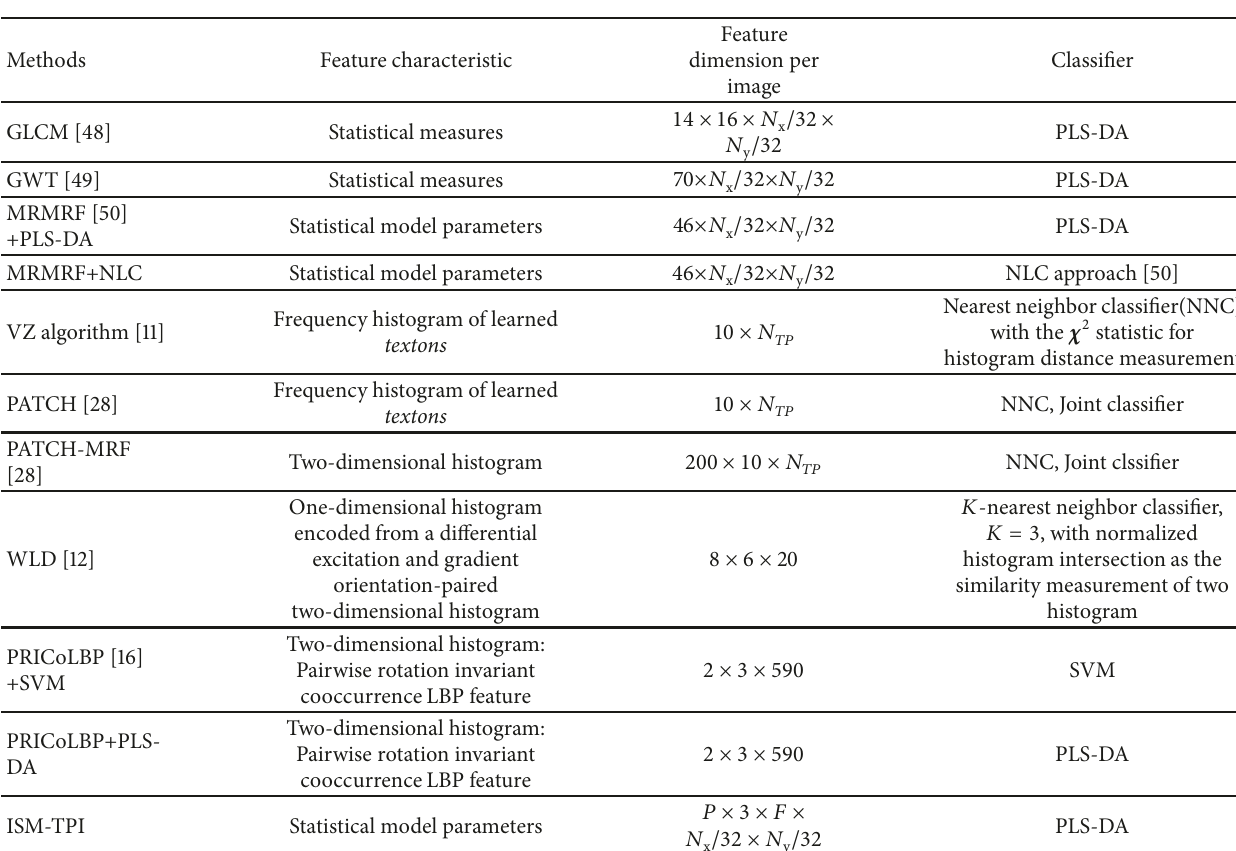
Table 2: Summary of the comparative